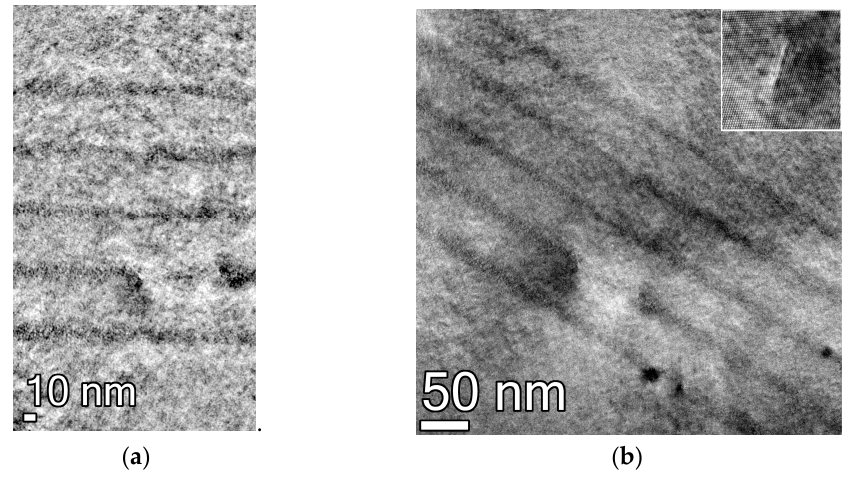
Figure 1. ( a ) Bright field micrograph of five Hg(Cd)Te QWs. The weak Z-contrast gives the widths of QWs d = 8–12 nm; ( b ) Overview of bright field micrograph with dark defected areas. A high- resolution image of a typical defected area is given in the inset.